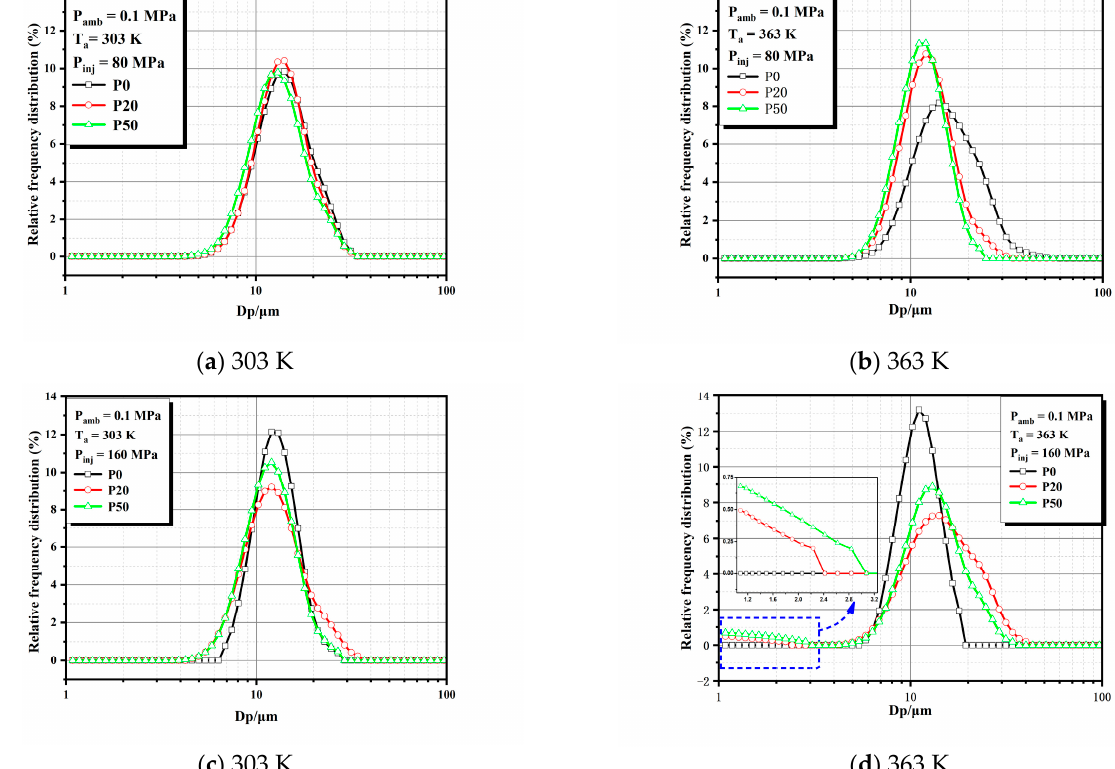
Figure 16. The effects of different temperature and IPs on the droplet size distribution.